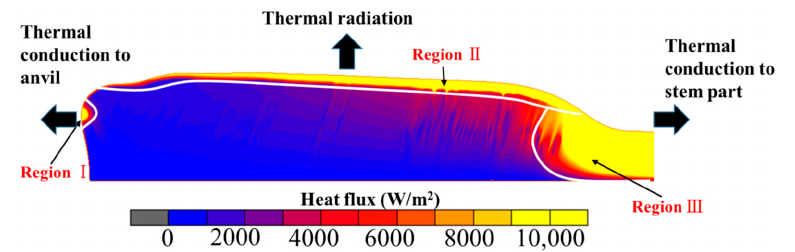
Figure 22. Heat flux distribution of billet at the end moment of the electric upsetting process.